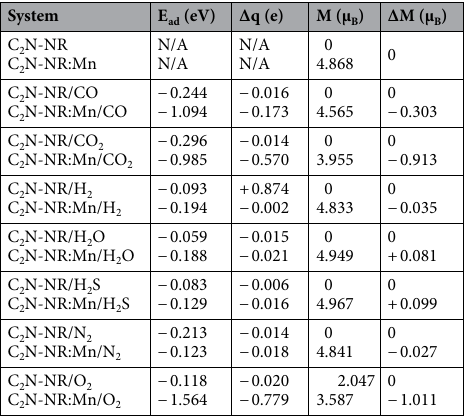
Table. 1. Adsorption energetics (i.e., E ads = adsorption energy) and magnetization of C 2 N-NR and C 2 N- NR:Mn before and after adsorption of gas molecules. Charge transfer (Δq = q − q o ), magnetization (M), and change of magnetization (ΔM = M − Mo). All the samples are